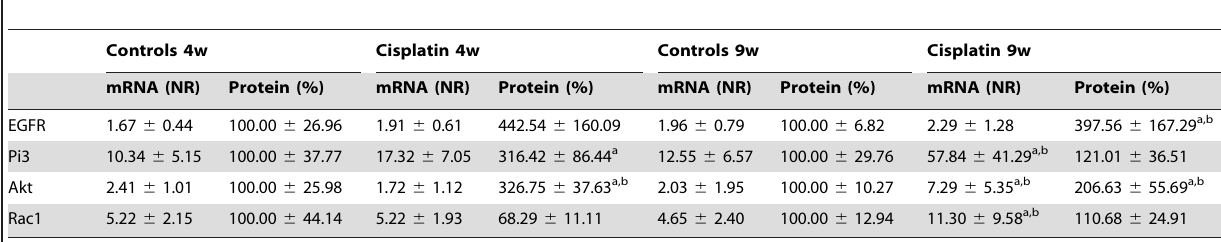
Data are presented in 4 groups: control animals receiving vehicle only, cisplatin-treated animals (2.5 mg/kg/w during 3 weeks) at 4 and 9 weeks after treatment with vehicle or cisplatin. Protein expression levels are presented as % 6 SD compared to the control group at 4 weeks and at 9 weeks. mRNA expression levels are presented as mean normalized ratio (NR) 6 SD. Statistics were performed using generalized linear models. a p , 0.05 versus controls at 4 weeks, b p , 0.05 versus controls at 9 weeks.